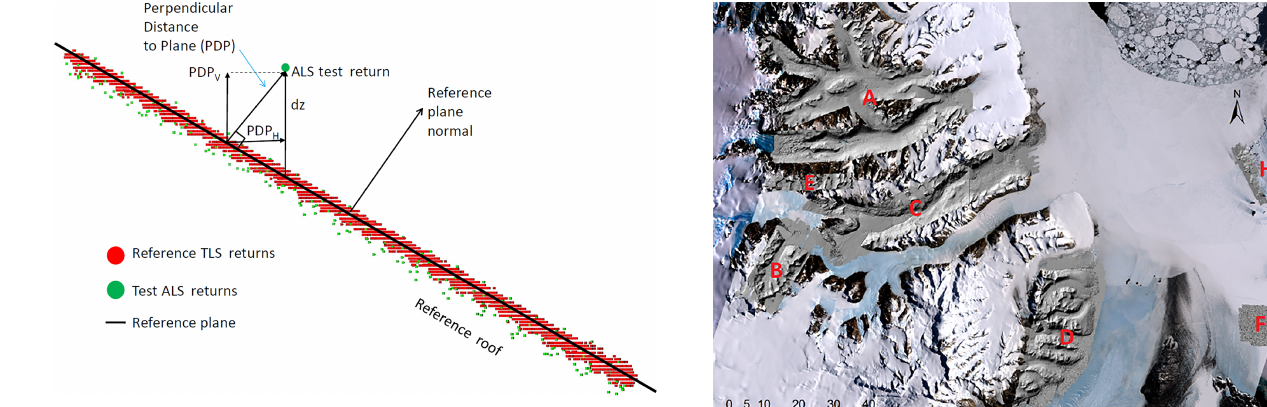
Figure 7. Illustration of assessing uncertainty for airborne lidar sur- vey (ALS) compared to terrestrial lidar survey (TLS) of an inclined roof.